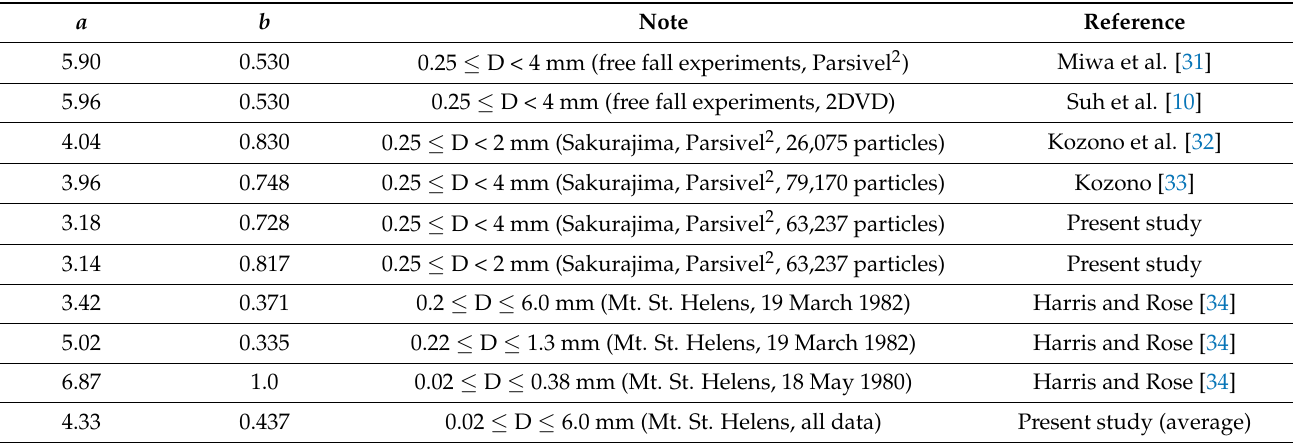
Table 3. List of coefficients and exponents of ash particle fall velocity formulae proposed in previous studies. V t ( D ) = a D b , where V t is expressed in m s − 1 and D is expressed in